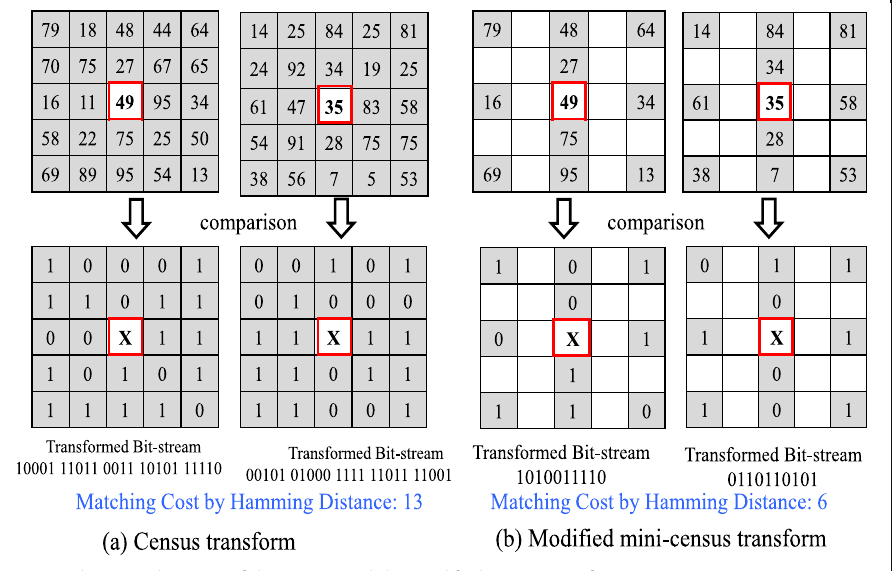
Fig. 2 Schematic diagrams of the census and the modified census